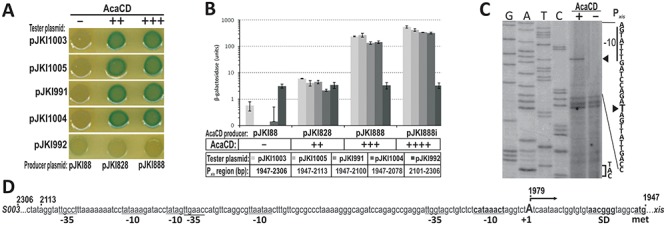
Analysis of promoter region Pxis. (A) Drop test of different regions of Pxis in the presence of AcaCD. The assay was carried out with TG1 strain containing the tester plasmids pJKI1003, pJKI1005, pJKI991, pJKI1004 and pJKI992 and AcaCD producer plasmids pJKI828 or pJKI888, respectively. Coordinates of Pxis regions are shown in panel B (see also Supplementary Figure S5). Vector pJKI88 was used as negative control. (B) β-Galactosidase assay of different regions of Pxis in the presence of AcaCD. Experiment was carried out as described in Figure 3. (C) Determination of xis TSS. Extension reactions were performed using primer pUCfor21 and total RNA purified from E. coli TG90 carrying tester plasmid pJKI1003 ± AcaCD producer plasmid pJKI888 (lanes + and −). Lanes G, A, T, C: Sanger sequencing reactions obtained using pUCfor21 and pJKI1003 template DNA. Arrowheads point to the T base on the non-transcribed strand corresponding to the A located 28 bp upstream to the ATG codon on the sense strand. The putative −10 box and the start codon are indicated. The presence (+) or absence (−) of AcaCD is shown. (D) Proximal fragment of xis promoter region. Coordinates above the sequence refer to published SGI1 sequence. The startpoint of xis transcript (uppercase A) and the deduced Shine-Dalgarno, −10 boxes are in bold, other potential −10 and −35-like elements are also indicated.